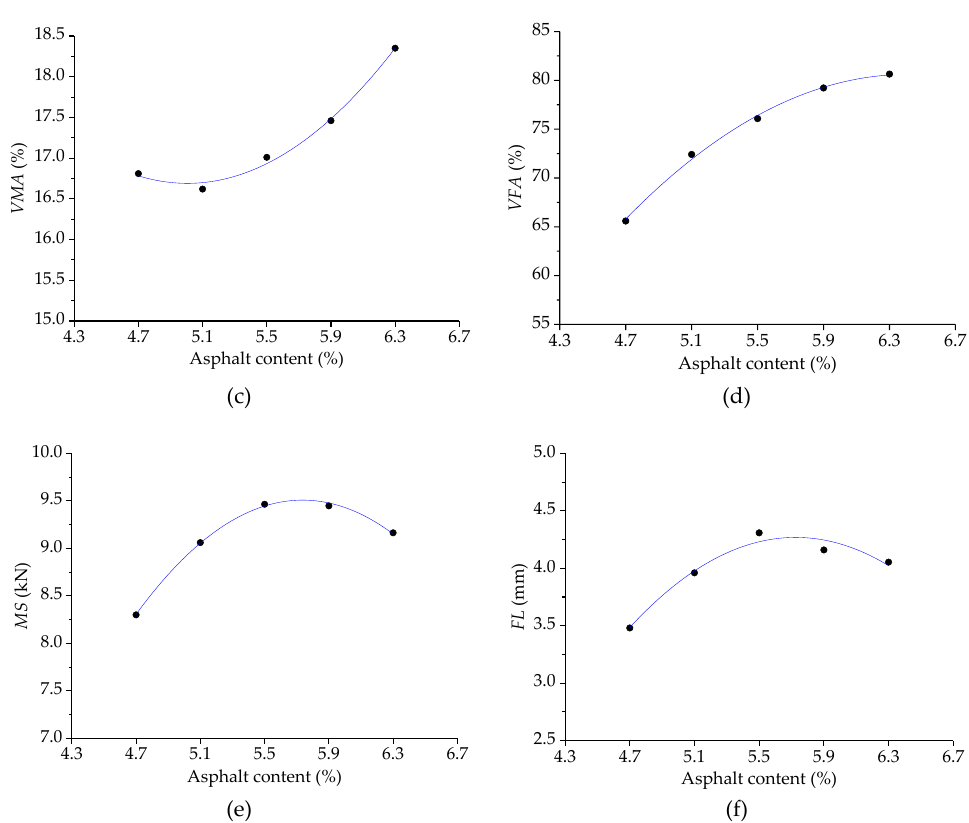
Figure 8. The Marshall mix design results of asphalt mixture with basalt fiber: ( a ) Bulk specific gravity, ( b ) VA , ( c ) VMA , ( d ) VFA , ( e ) MS , and ( f ) FL .